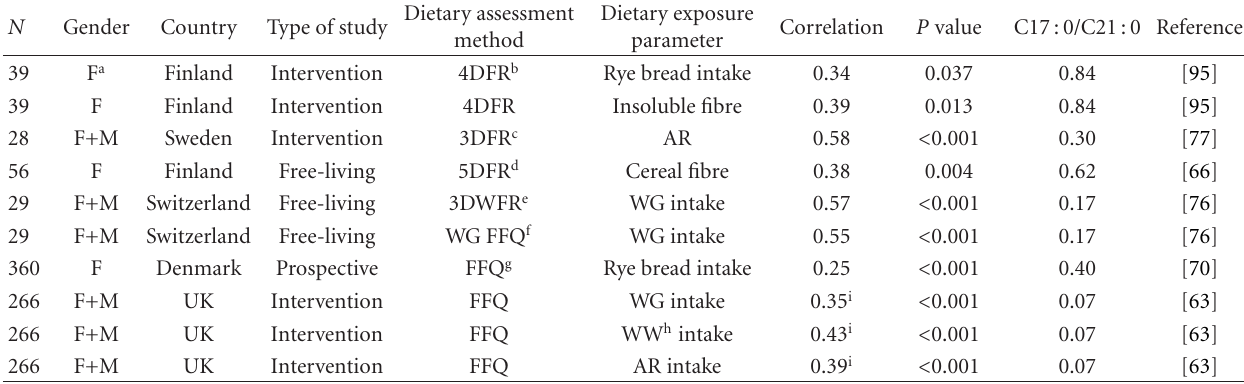
Table 2: Correlations of plasma alkylresorcinol concentration with di ff erent measurements of wholegrain intake from previously published studies.